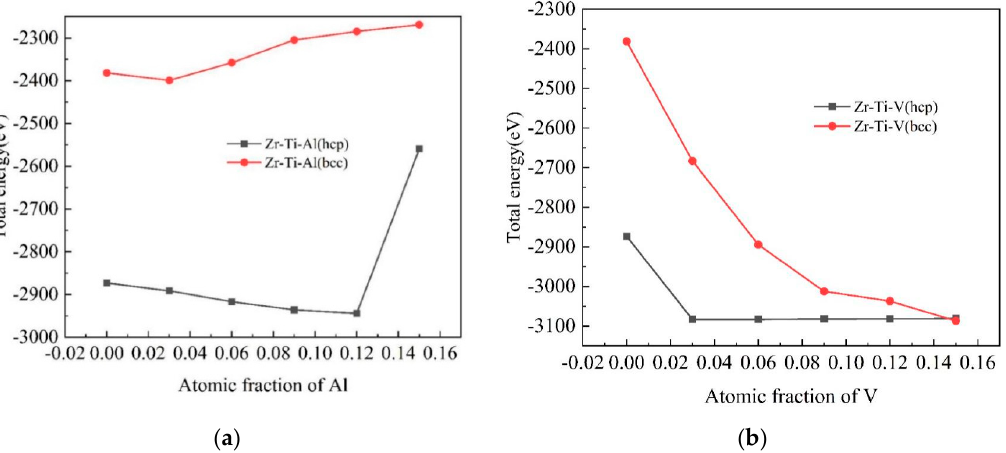
Figure 3. ( a ) Effect of Al atom fraction on total energy of Zr-Ti-Al alloy systems; ( b ) effect of V atom Figure 3. ( a ) E ff ect of Al atom fraction on total energy of Zr-Ti-Al alloy systems; ( b ) e ff ect of V atom fraction on total energy of Zr-Ti-V alloy systems. fraction on total energy of Zr-Ti-V alloy